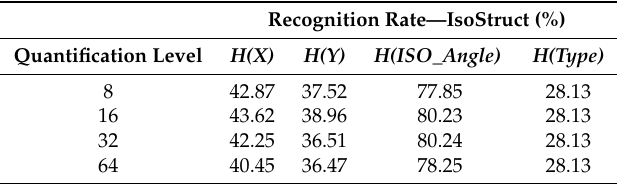
Table 9. Fingerprint classification results for each component of the IsoStruct features